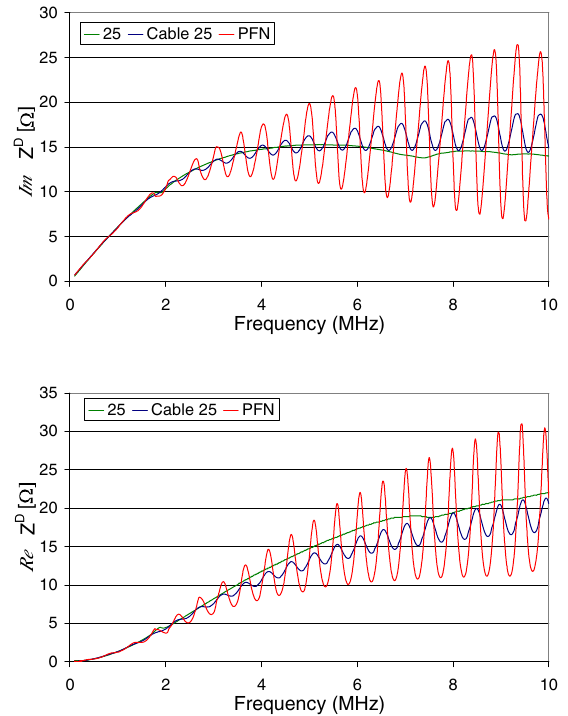
FIG. 15. (Color) Direct impedance with 25 (cid:16) , cable with 25 (cid:16) , or cable with